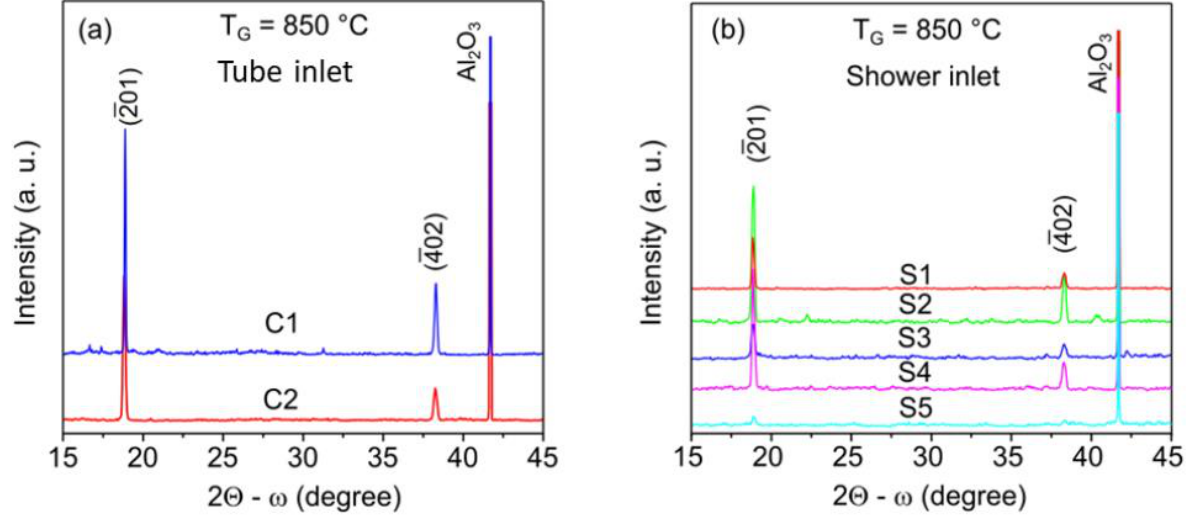
Figure 6. XRD spectra of β -Ga 2 O 3 layers grown on sapphire (0001) using a tube ( a ) and a shower head ( b ) as the gas inlet. The spectra are shifted vertically for clarity.